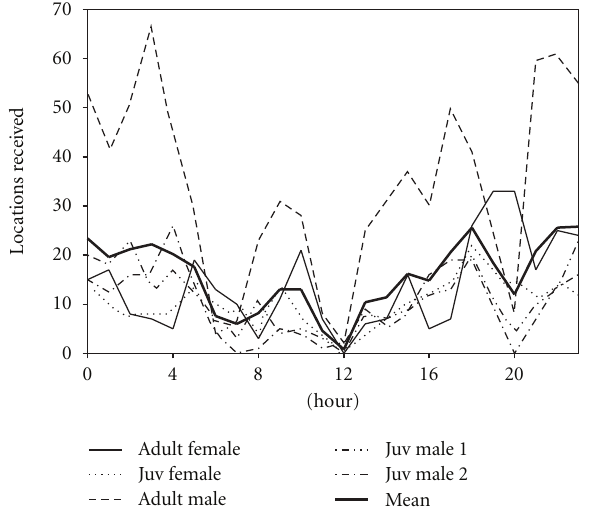
Figure 3: Locations of all five falcons showing the time of day the location was